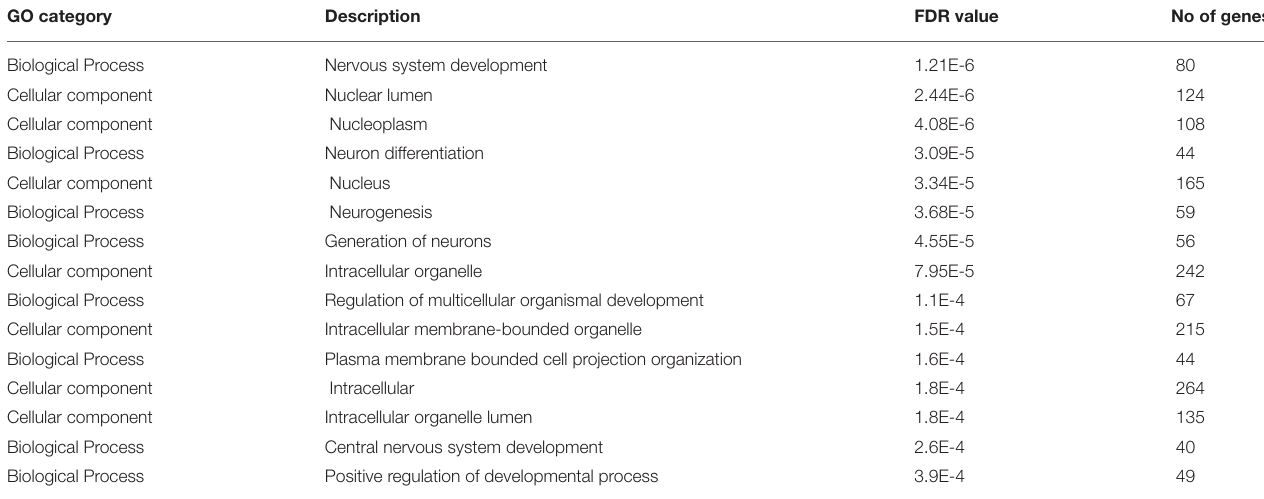
TABLE 6 | Gene ontology (GO) terms with the strongest enrichment in the analysis of the differentially downregulated transcripts in the comparison between alpha-synuclein-overexpressing and GFP-expressing LUHMES cells.